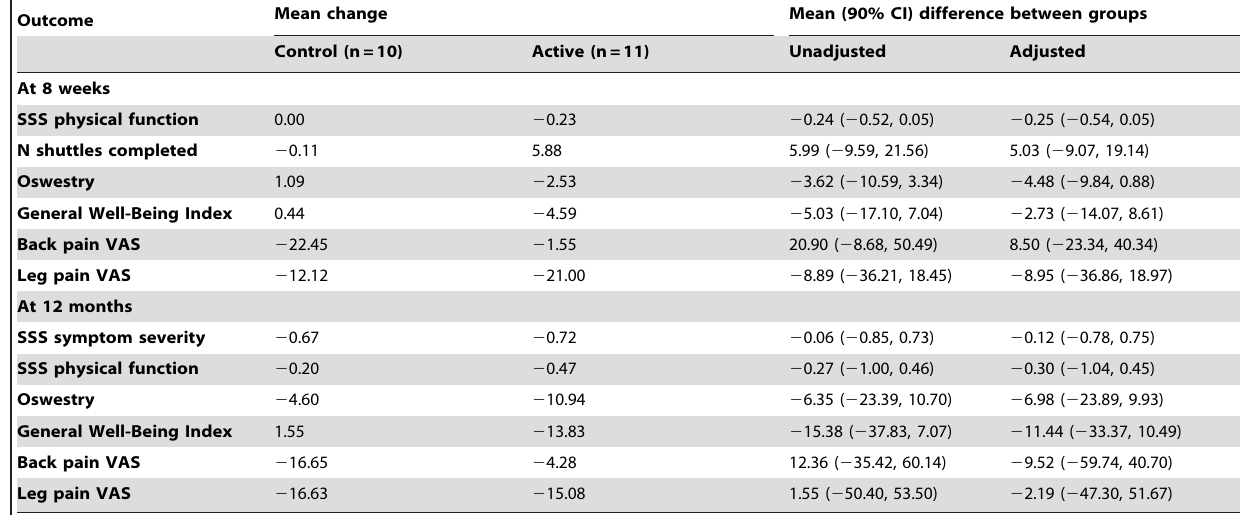
Table 5. Changes in secondary and exploratory outcomes in a subgroup of patients with symptom severity scores exceeding the 75 th percentile at